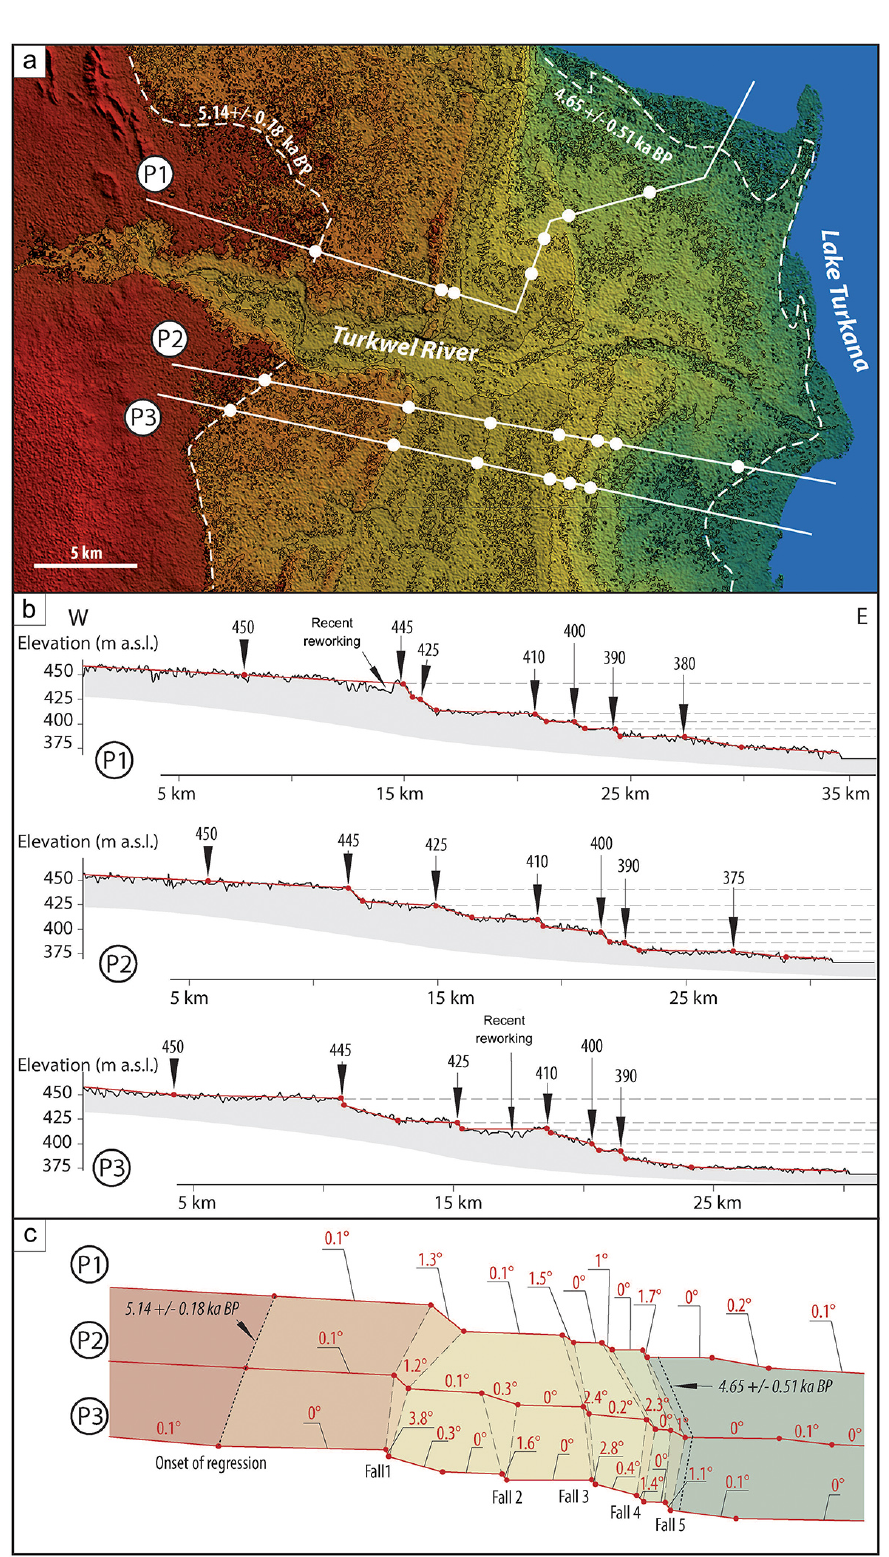
Figure 3. Geomorphological data for the Turkwel delta complex. For location, see Fig. 1b. (a) SRTM1 images were processed to display a digital elevation model of the Turkwel delta complex. Locations of the topographic transects are presented. (b) Topographic transects P1, P2, and P3. (c) Trajectory analyses show that the overall forced regressive trend (<0.4 ◦ ) is punctuated by five steeper slopes (1 to 3.8 ◦ ) revealing short-term increases in the rates of lake level